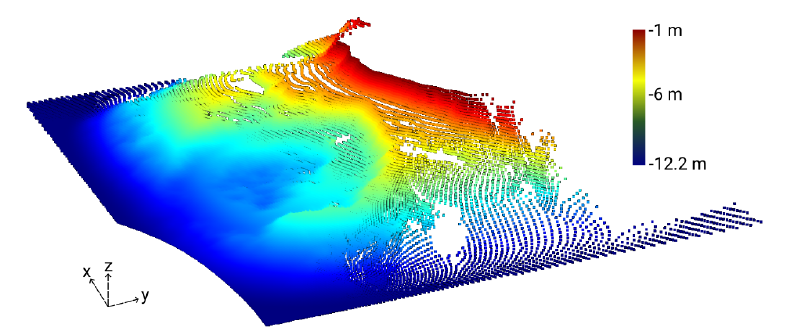
Figure 17. Side scan sonar results for synthetic data generation of point cloud data (perspective view). The color coding of the point cloud refers to the height level, not to the classification. Labeling is not included here. This makes sense if objects or object classes are included in the virtual scene whose classification and automatic separation are worthwhile. This can be, e.g., fish